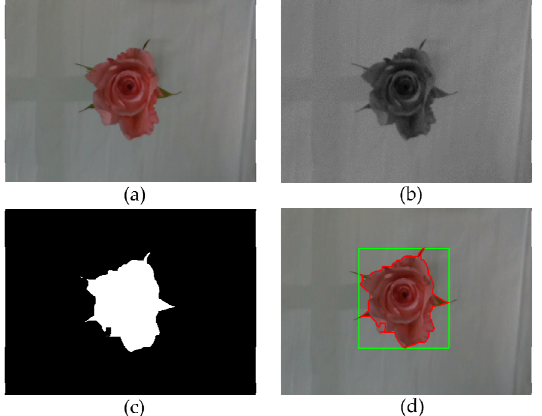
Figure 6. Flower bud image detection: ( a ) original image, ( b ) grayscale image, ( c ) binary image, and ( d ) flower bud region.